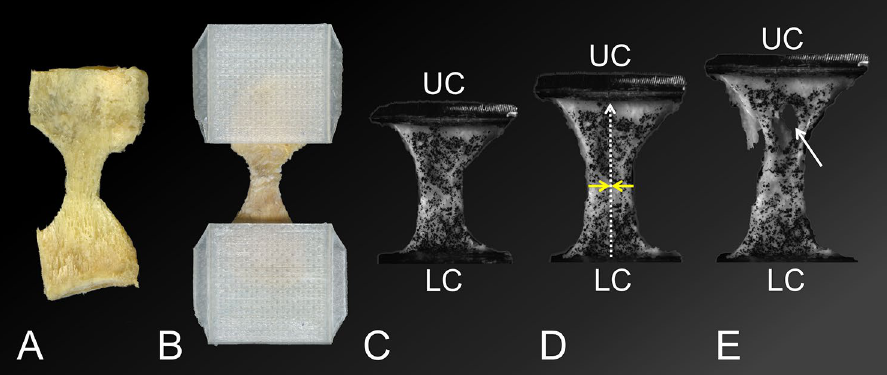
Figure 1. The images display the preparation steps of samples for tensile testing and the subsequent uniaxial load application at different testing stages. ( A ) A lateral calcaneal periosteum sample is depicted after it has been cut into a “dog bone” shape (view from inside). ( B ) The sample from A was mounted into 3D-printed squeezing clamps (view on the sample from outside). ( C ) Speckled and mounted sample in the material testing machine, upper (UC) and lower (LC) clamp. ( D ) A load is applied to the sample, indicated by the UC crosshead displacing cranially. The sample elongates (represented by the dotted arrow) and narrows in the ‘shaft’ region of the dog bone, indicated by the yellow arrows. ( E ) Continuous load application causes tearing of the sample (indicated by the white arrow).